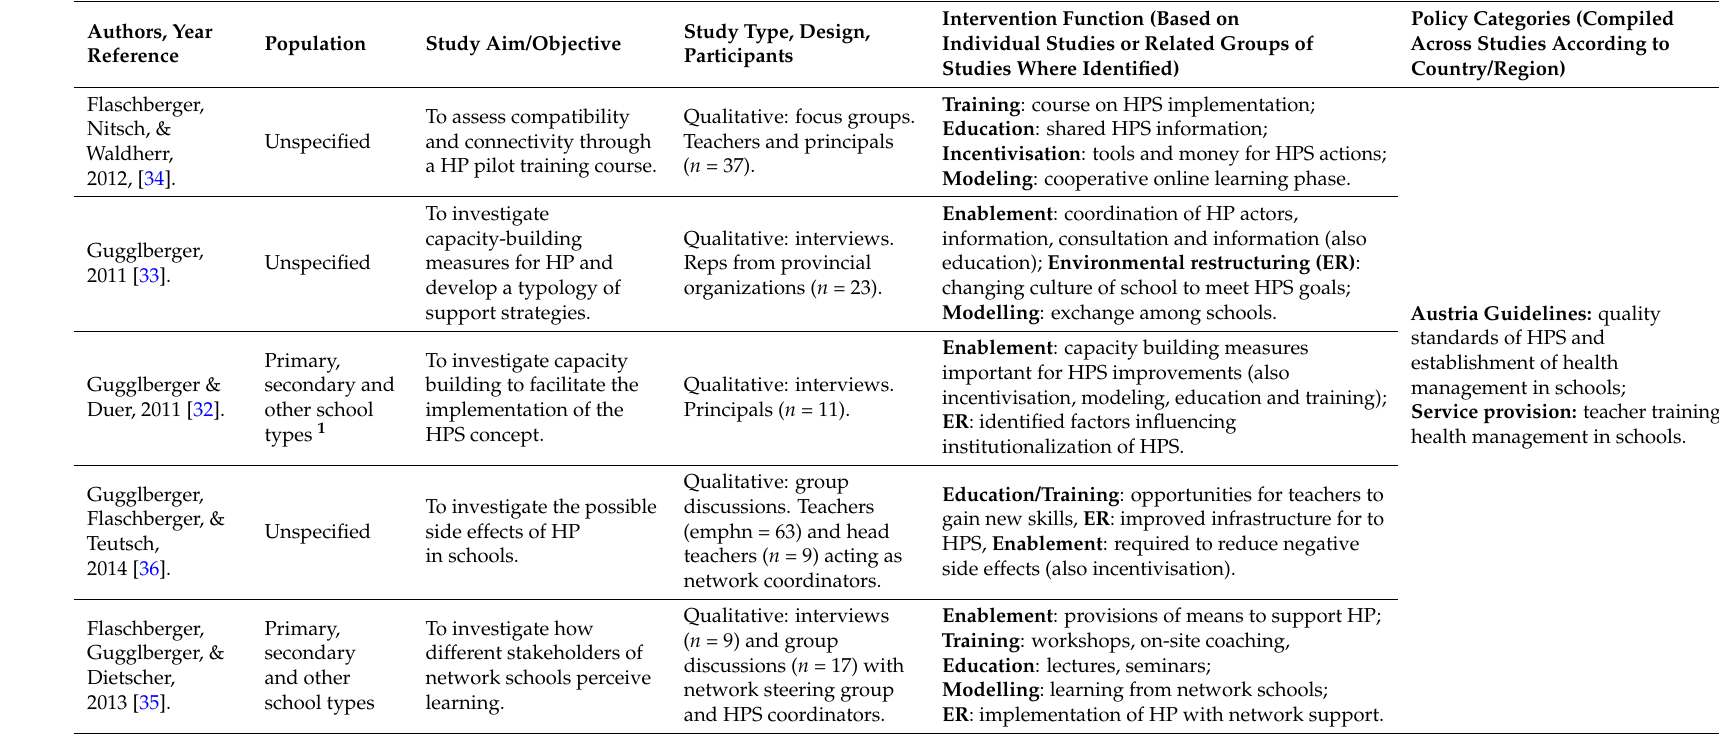
Table 3. Overall study results (HPS = health promoting schools; HP = health